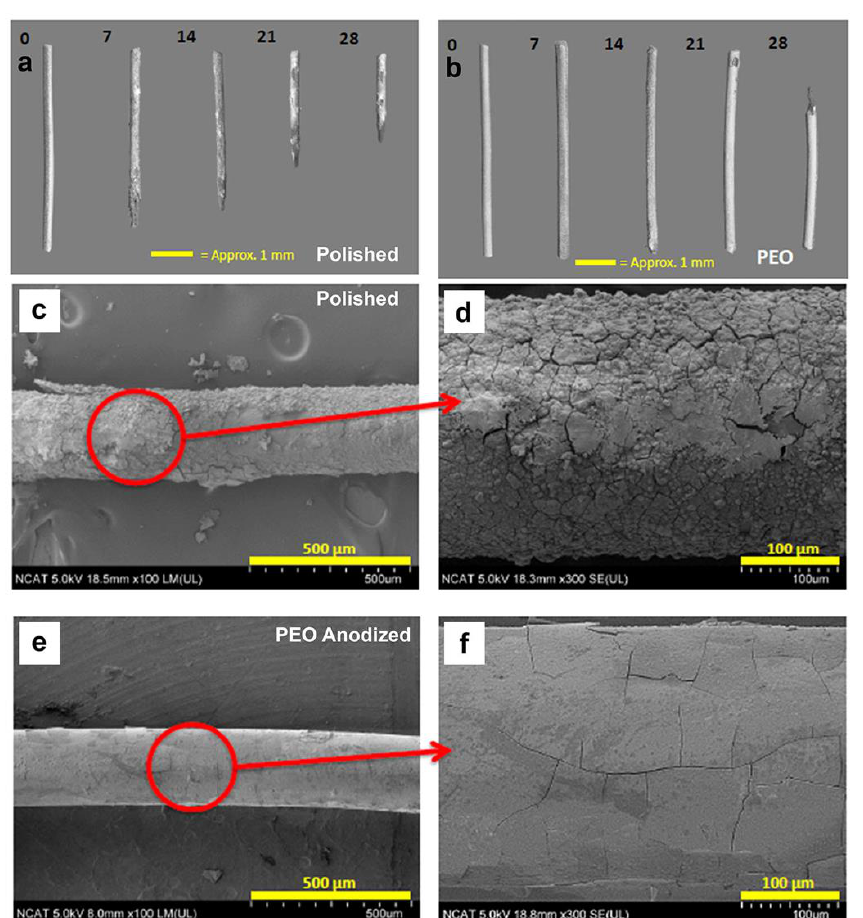
Figure 3. ( a , b ) Micro-CT images of Mg filaments before and at each week after suspension in HBSS for up to 4 weeks, showing 3D renderings. ( c – f ) SEM images of 4-week samples, showing surface morphology of a polished ( c , d ) and PEO-anodized ( e , f ) Mg filament at different magnifications. With copyright permission from [35].